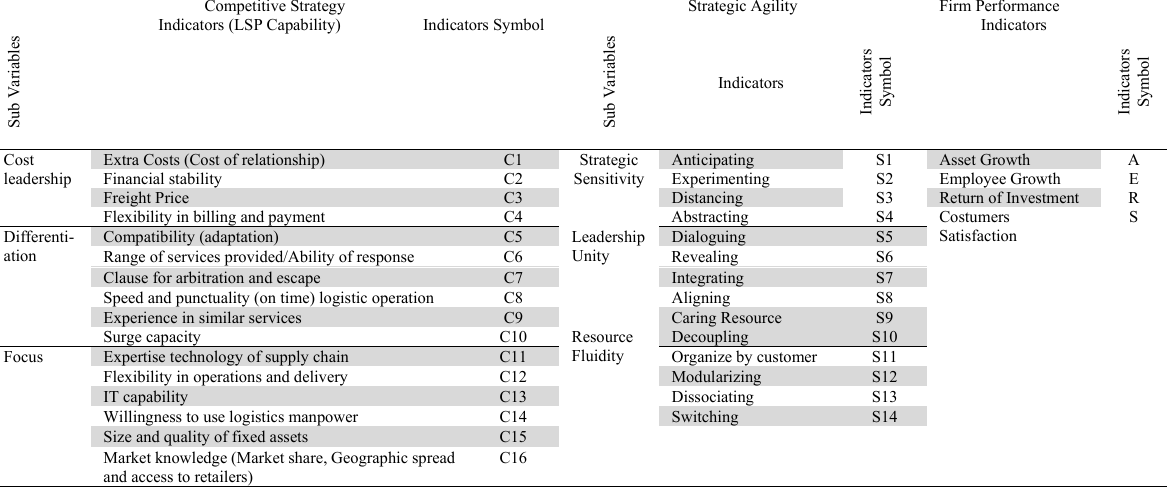
Variable Operationalization of Competitive Strategy, Strategic Agility, and Firm Performance Competitive Strategy